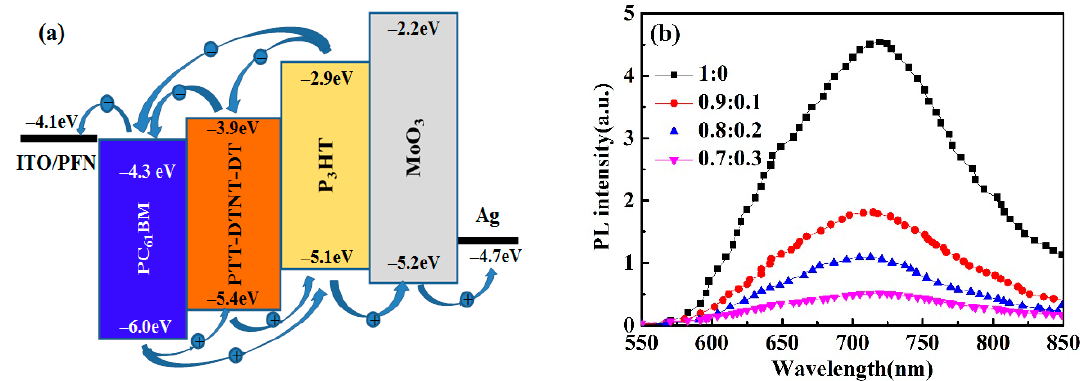
Figure 4. ( a ) Schematic diagram of energy level structure of ternary OPVs; ( b ) PL spectra of different proportion P3HT:PTT-DTNT-DT blend membranes.